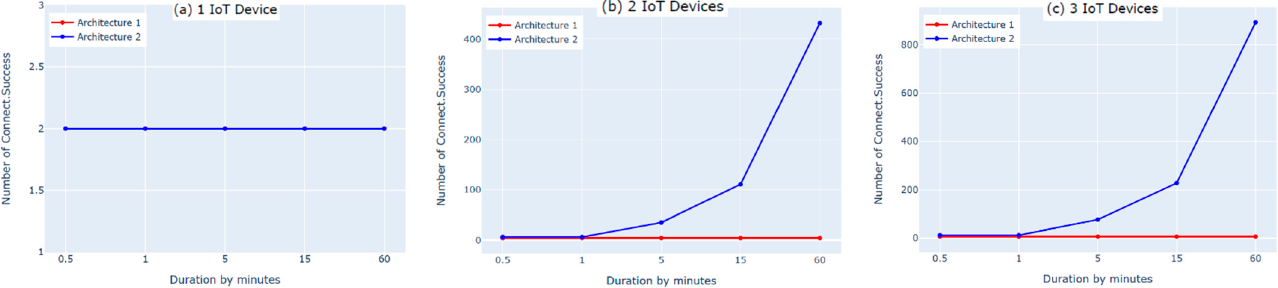
Figure 8. AWS IoT message broker Connect Success metrics with 1, 2, and 3 IoT devices on the North Virginia datacenter (cloud layer).